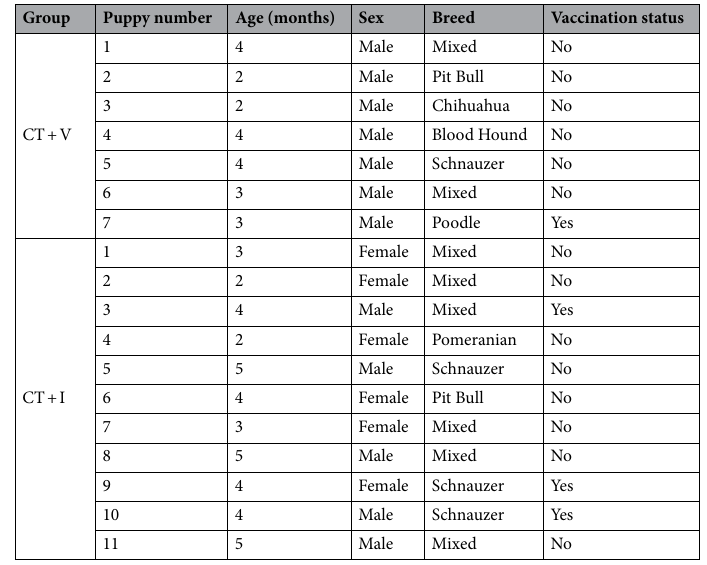
Table 1. Demographic characteristics of the study population. The number of puppies per group, age, sex, breed, and vaccination status is described. CT conventional treatment, I immunomodulatory, V vehicle.